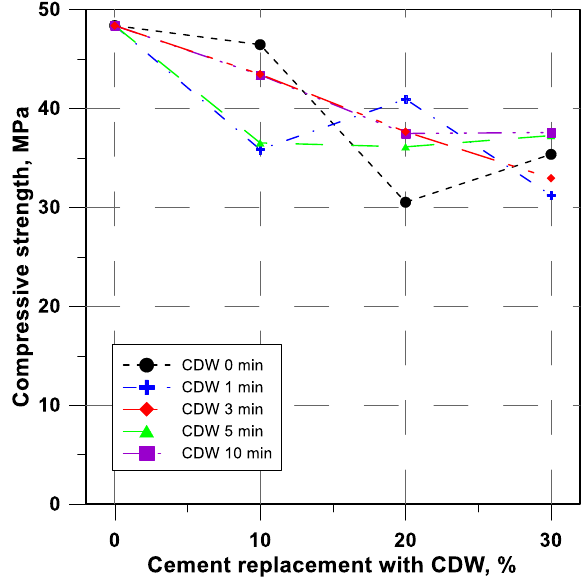
Figure 3. Results of compressive strength measurements.